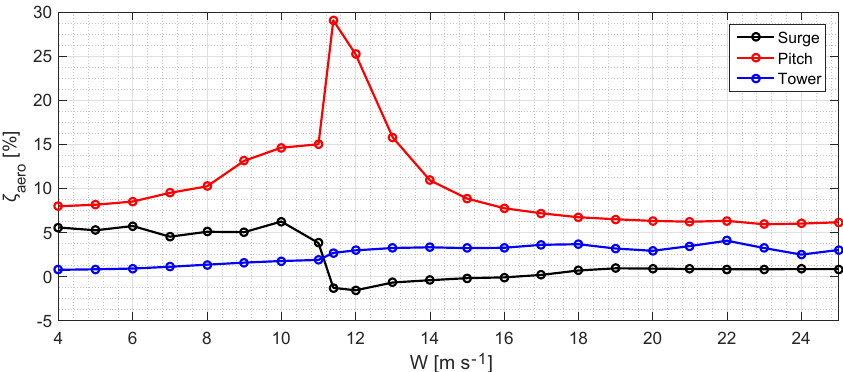
Figure 5. Aerodynamic damping ratios for different DoFs as a function of wind